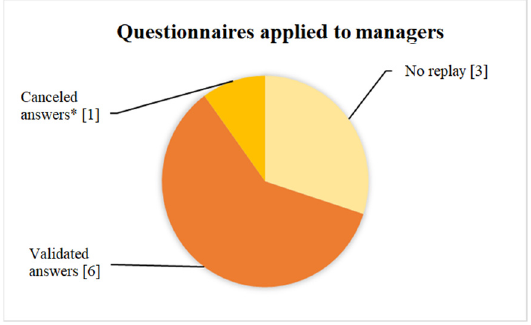
Figure 4. Graphical analysis for the distribution of the questionnaire.